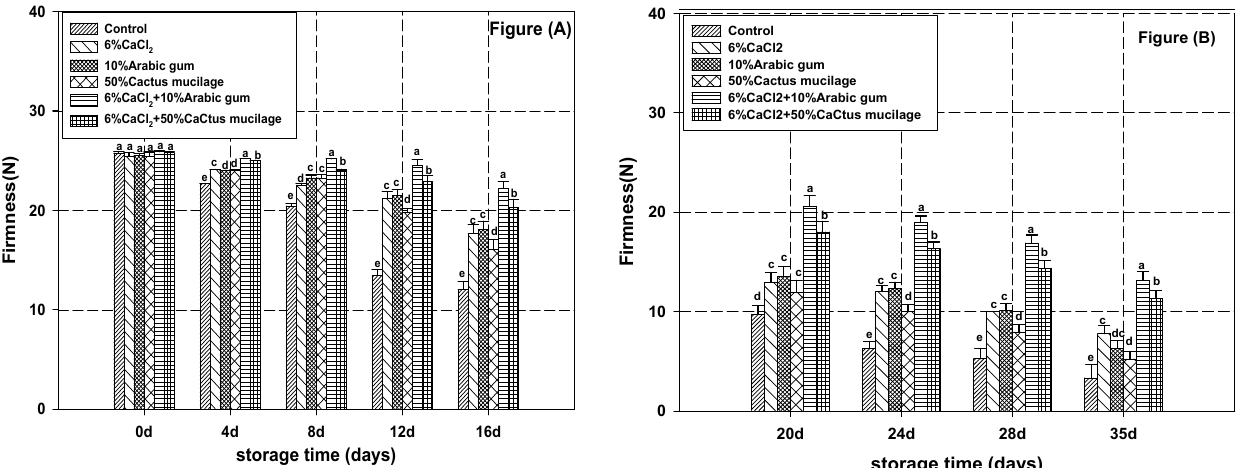
storage time (days)